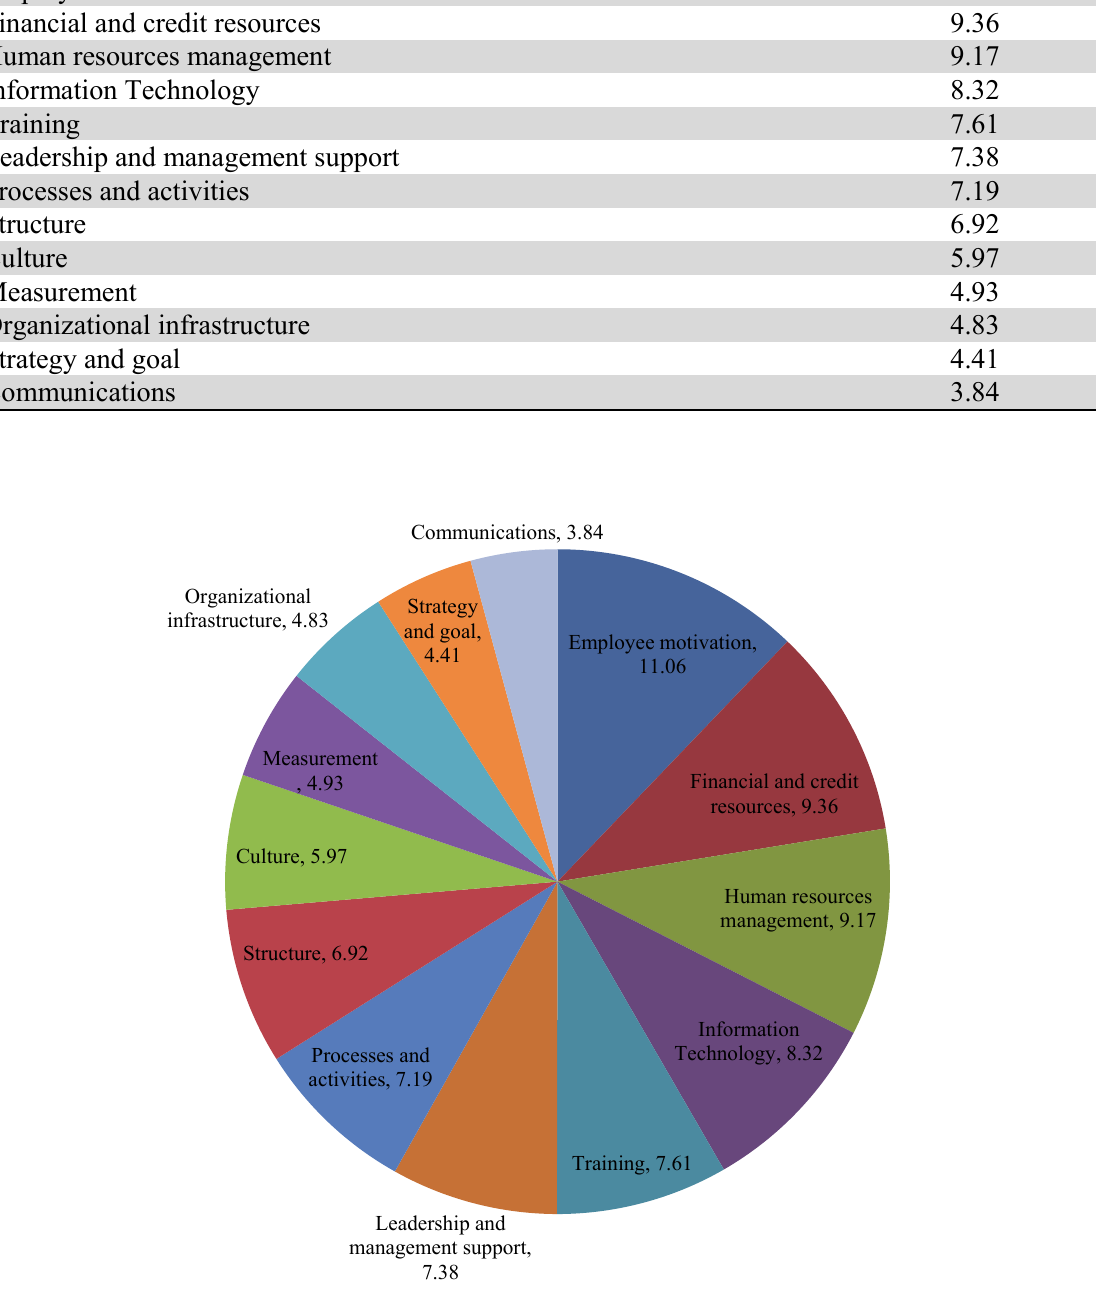
Fig. 2. Success Factors of Knowledge Management